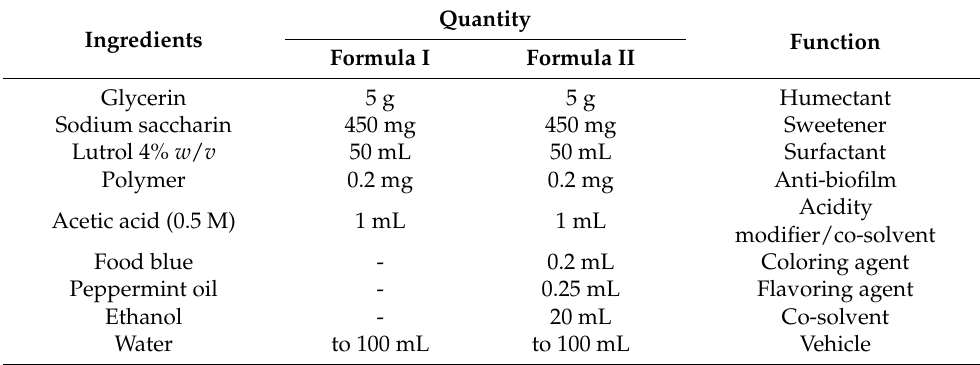
Table 1. Chitosan-based mouthwash formulation.